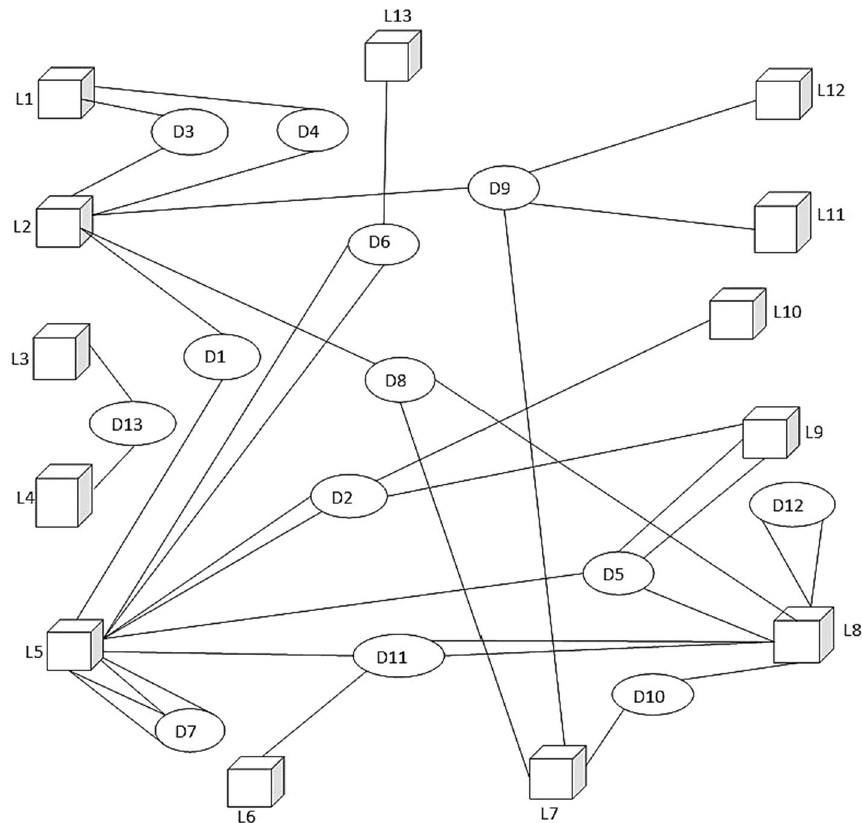
Fig. 9 The bipartite habitat suitability graph (Source: Liew 2016, p.